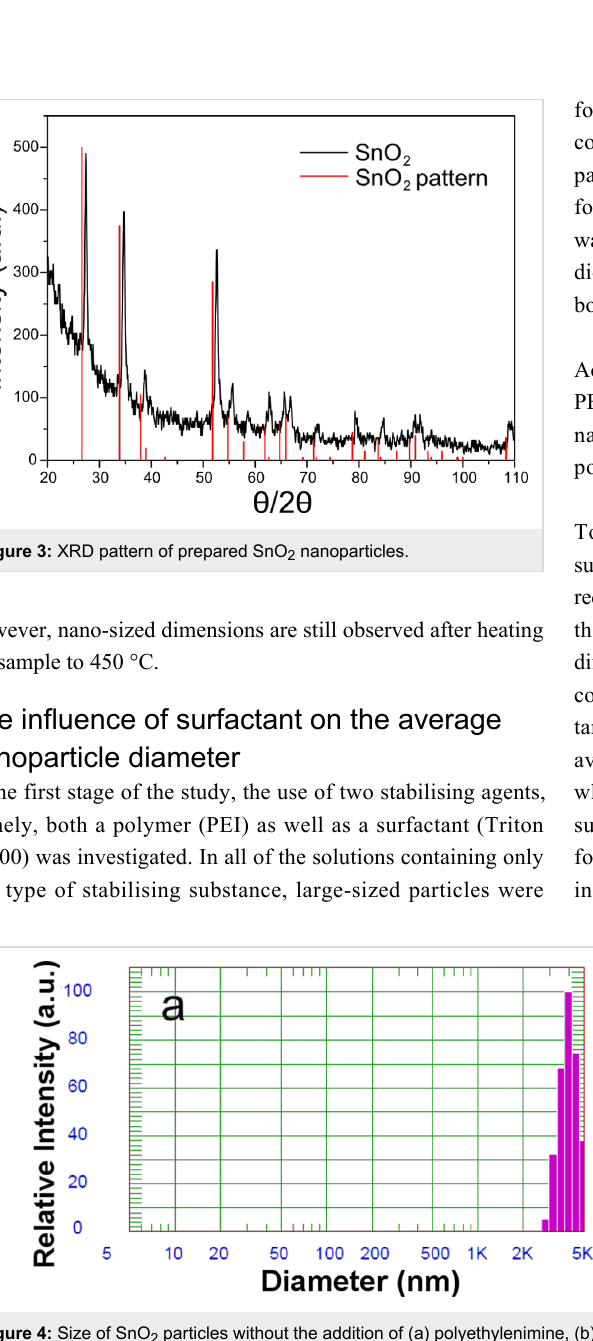
Figure 4: Size of SnO 2 particles without the addition of (a) polyethylenimine, (b) surfactant.